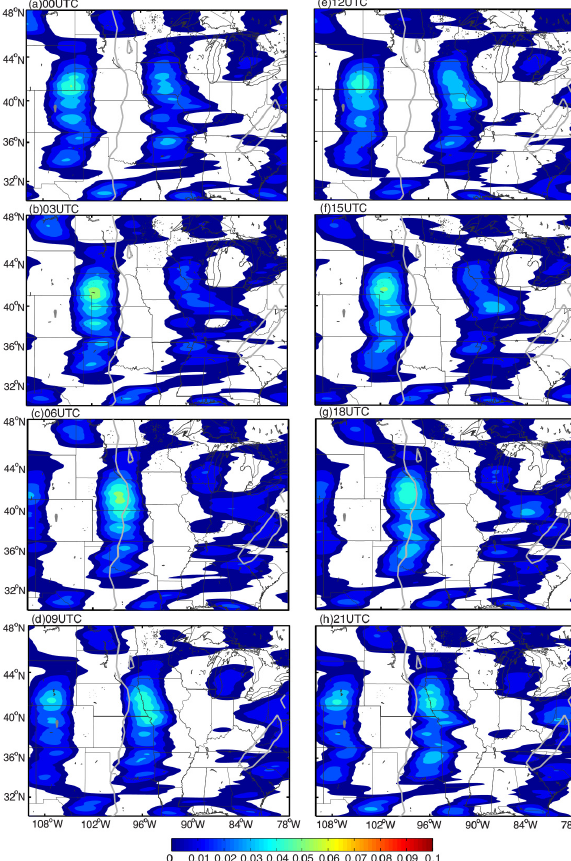
Figure 17. Similar to Fig. 14 but for SR2-filtered perturbations (units: mmh − 1 ) over North America.